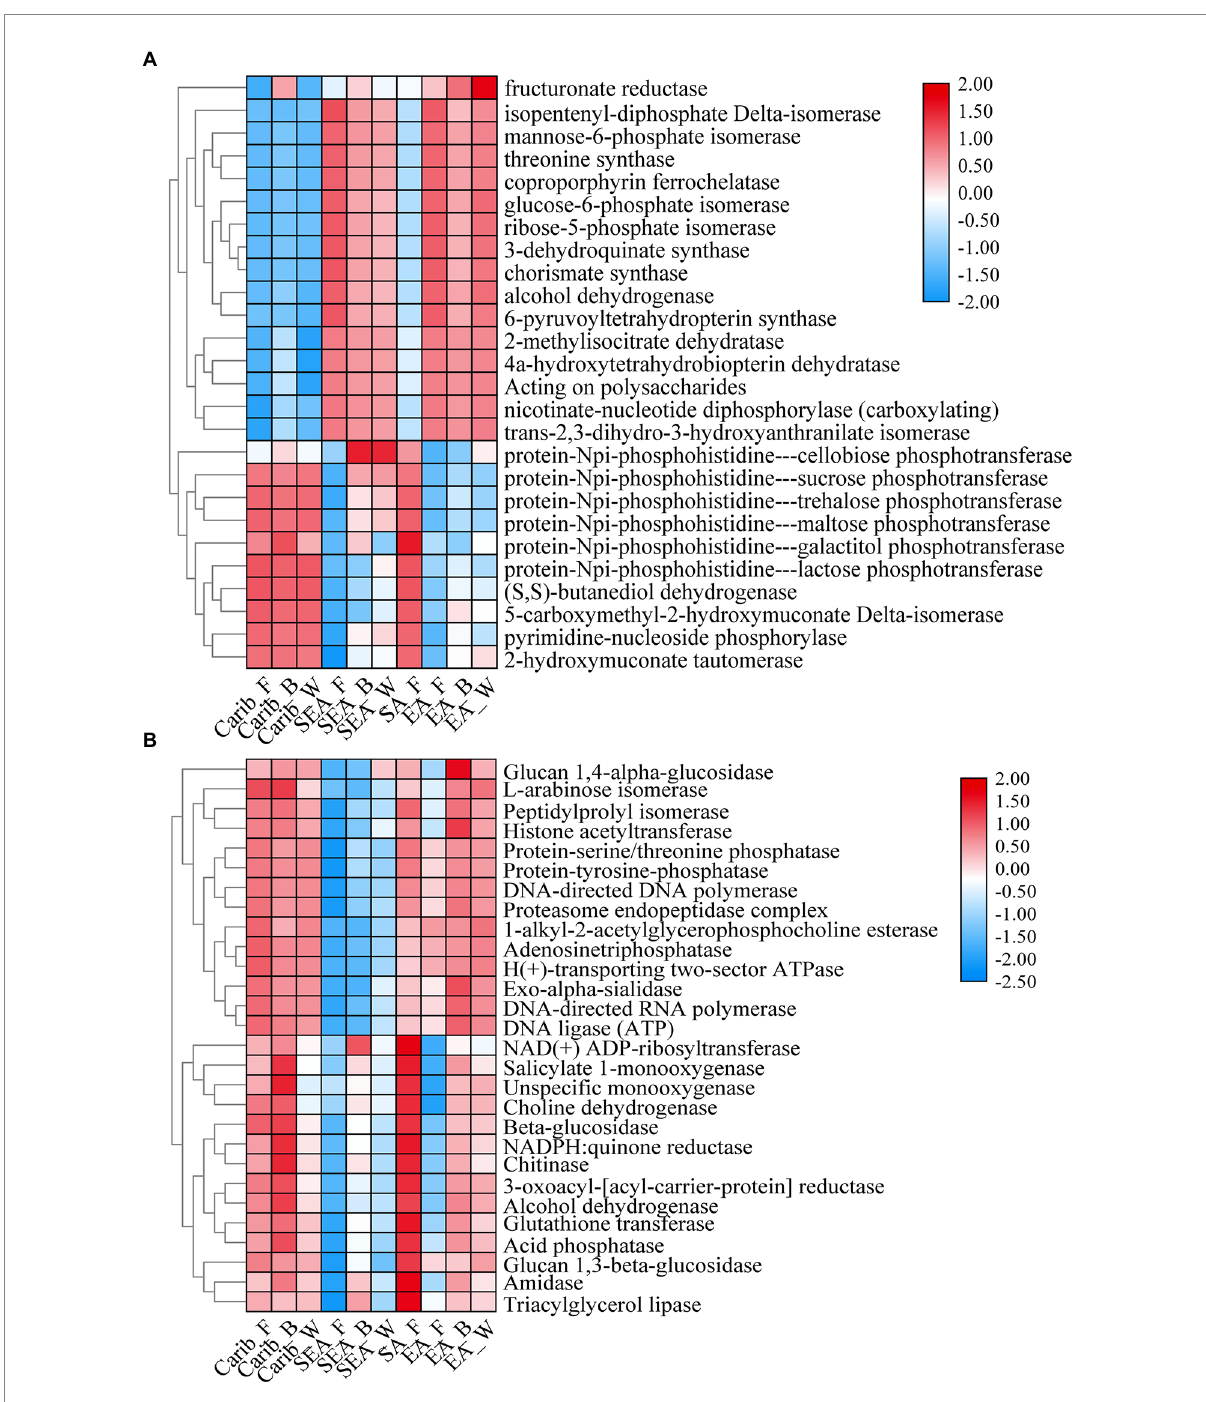
FIGURE 10 Functional heatmap of bacterial (A) and fungal (B) metabolic